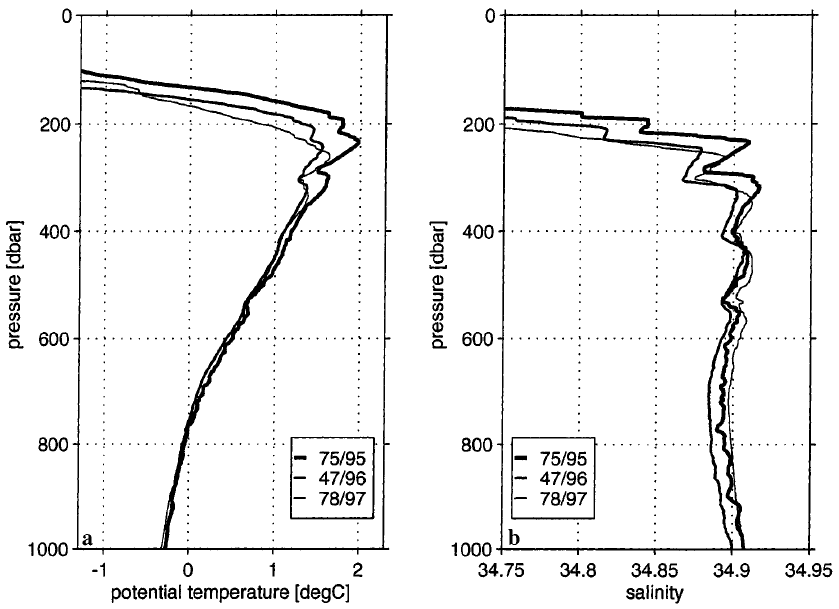
Fig. 11. a Temperature profiles and b sa- linity profiles from stations 75/97 , 47/96 and 78/97 along the Nansen–Gakkel Ridge showing the depths of